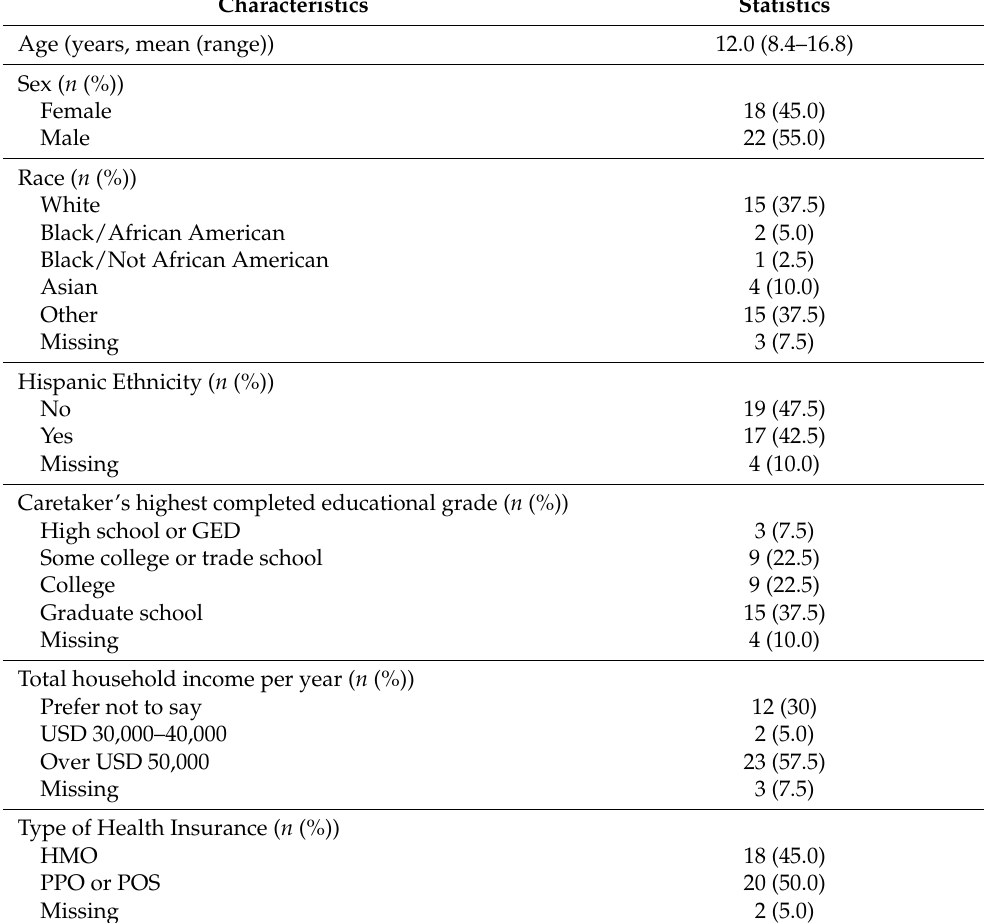
Table 1. Descriptive statistics of participant characteristics ( n =